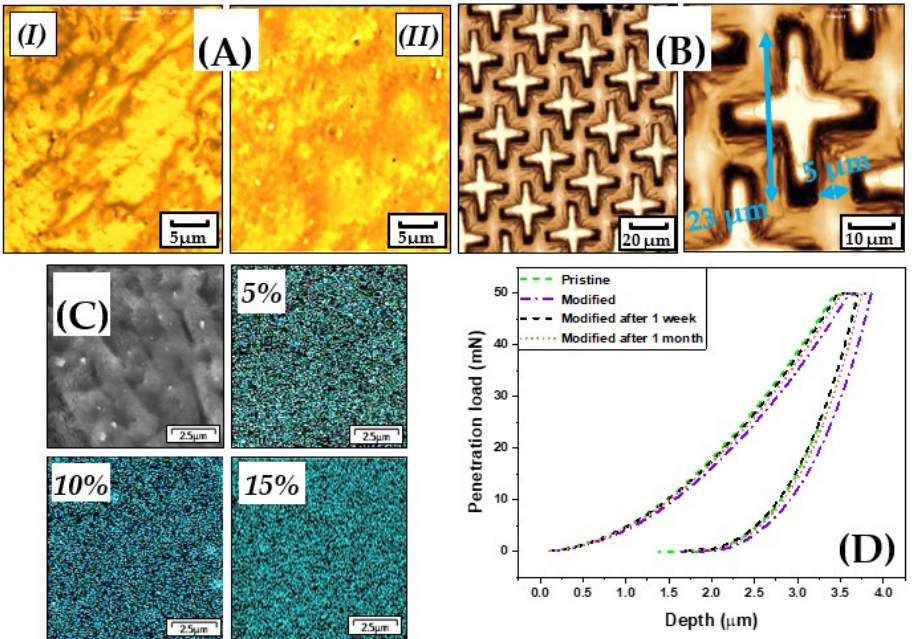
Figure 4. Surface morphology of pristine ( I ) and modified samples ( II ) determined by confocal microscopy ( A ); printed structures on the surface ( B ); overview of the surface of the modified samples measured by SEM and mapping distribution of AgNPs in different concentrations inside the samples acquired by EDX ( C ); load-depth of penetration instrumented indentation test data record of pristine samples, modified samples, and modified samples after releasing silver ions for one week and one month ( D ). Table 1. Mechanical characterization of different samples.